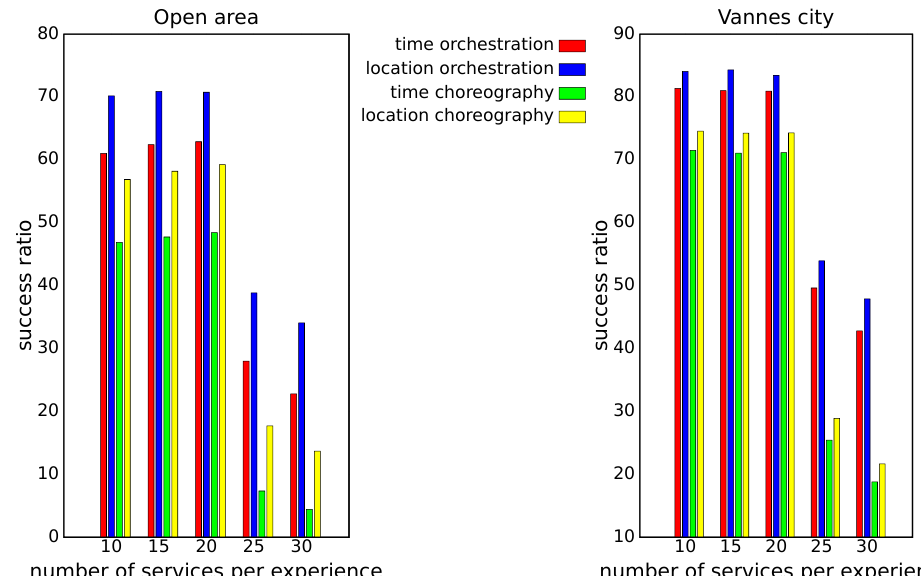
Figure 6. Success ratio against number of services per